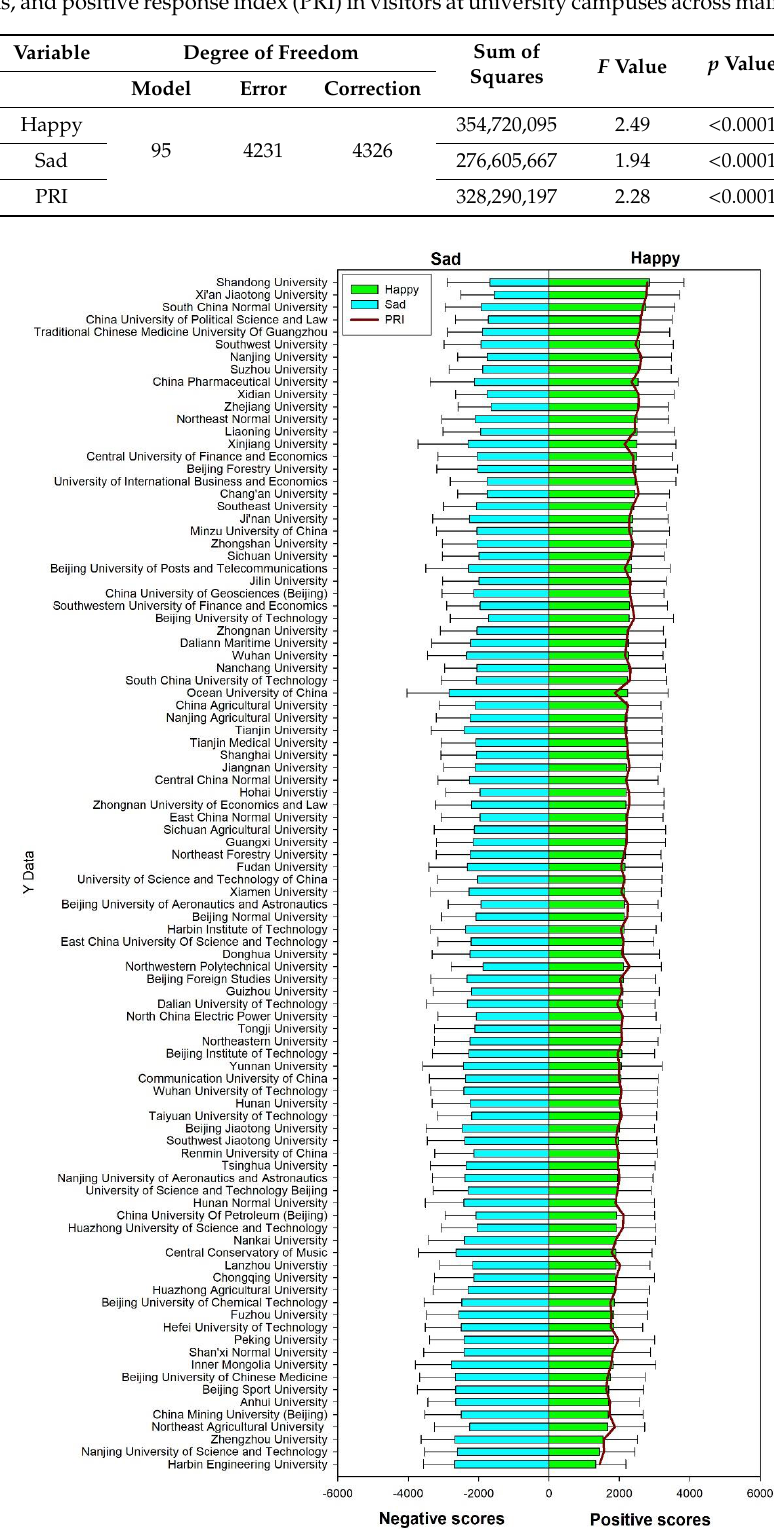
Table 2. Results of one-way analysis of variance (ANOVA) on ranked scores of happy and sad expressions, and positive response index (PRI) in visitors at university campuses across mainland China.